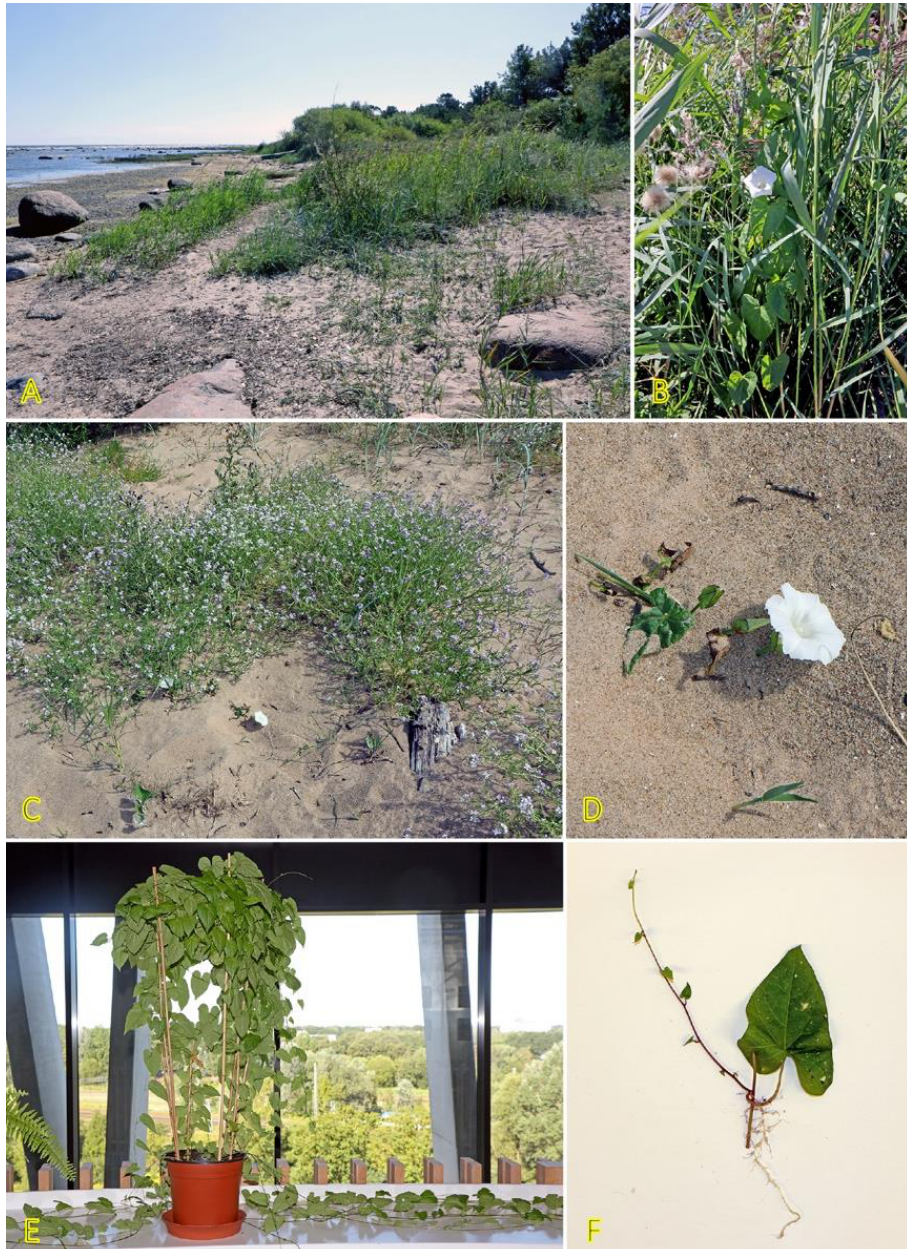
Figure 9. Characteristic coastal sandy beach habitat of Calsytegia sepium with Phragmites australis in Mērsrags, Latvia ( A ), plants on a beach habitat in Mērsrags, Latvia ( B ), plants on coastal embryonic dunes together with Cakile maritima in Salacgrīva, Latvia ( C ) with a detailed view ( D ), formation of plagiotropic rhizome-forming shoots in controlled conditions ( E ), formation of adventitious roots and new shoots at nodes of stem explants with leaf ( F ).